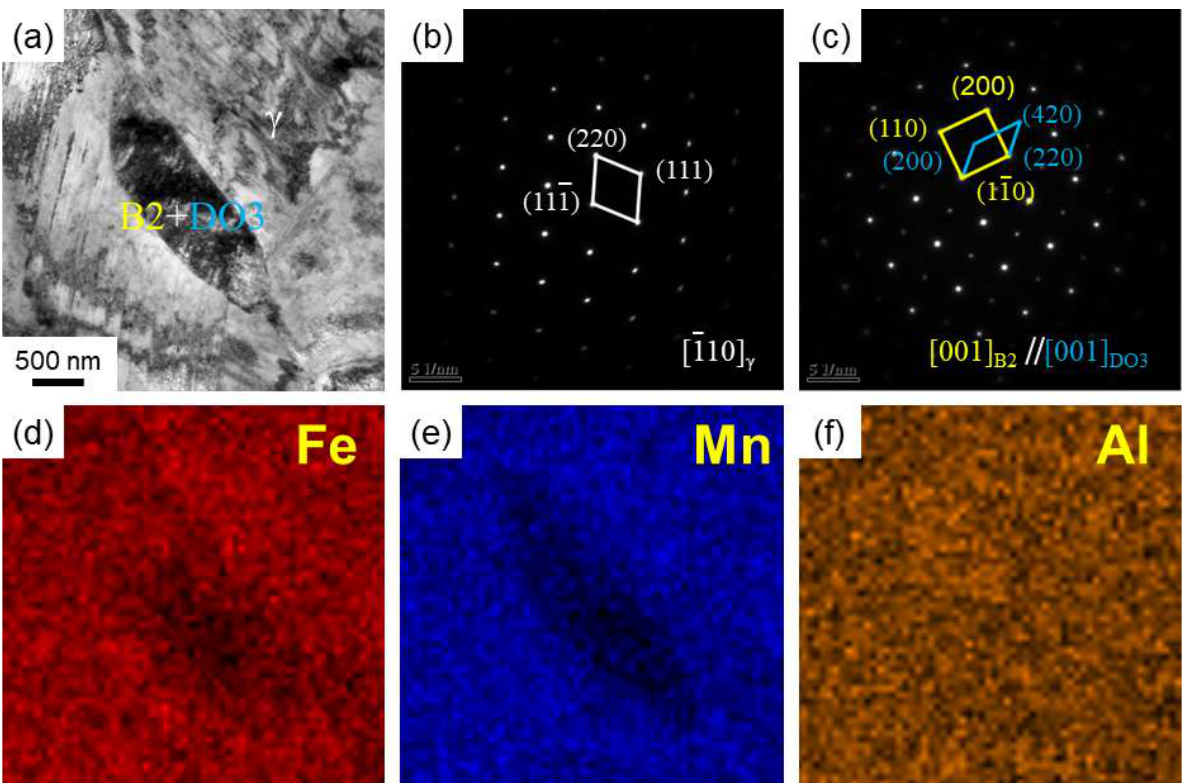
Figure 4. TEM analysis of the γ and B2+DO3 phases in S1000 samples: ( a ) TEM image, ( b , c ) SAD pattern analysis and ( d – f ) EDS mapping for Fe, Mn and Al.